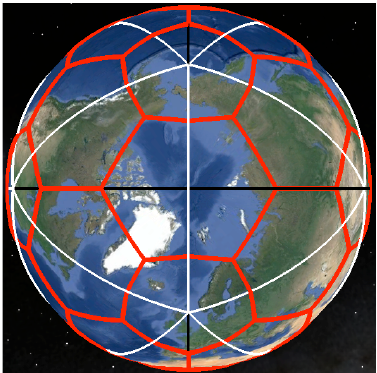
Figure 8. Cell boundaries for the aperture 4 first grid precision.